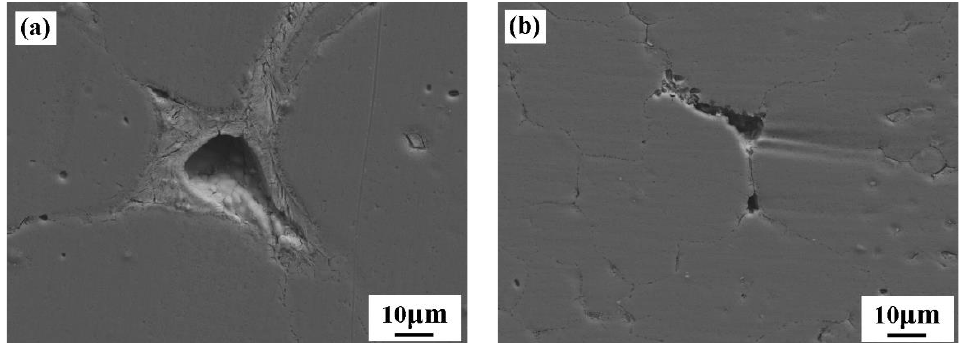
Figure 6. SEM images of inter-granular structure of samples of cup-shaped parts via semi-solid compressed at 620 °C: ( a ) sample located at the edge of the part; ( b ) sample located at the edge of the part.